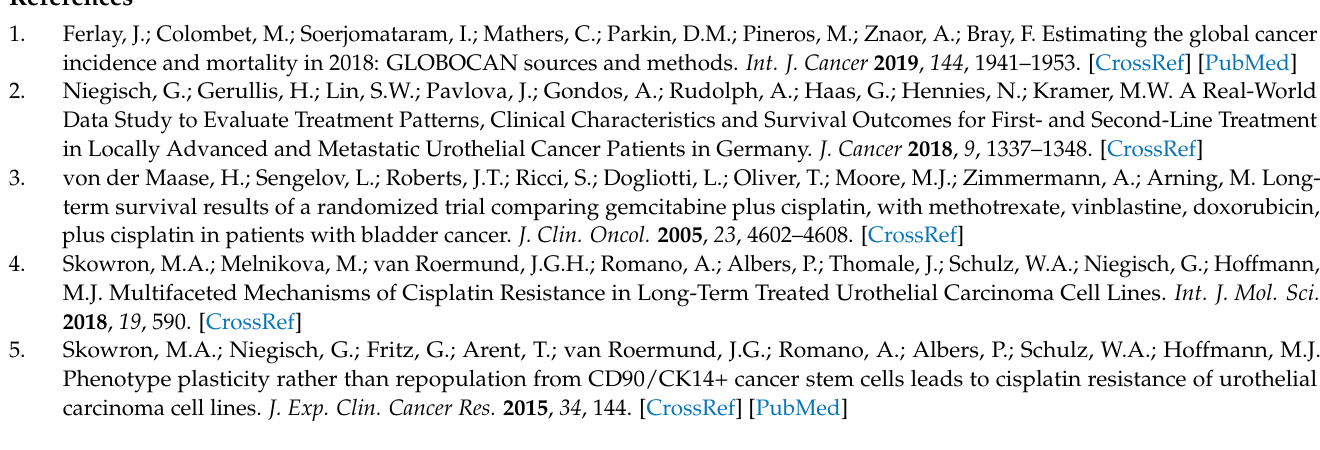
Figure S2: Impact of PLX treatment on HBLAK cells. Figure S3: Long term impact of PLX treatment on cell cycle. Figure S4: Synergistic effects on UCC by romidepsin treatment combined with PLX or cisplatin. Figure S5: Effect of combinations treatment with PLX on long-term proliferation and synergy of sequential combination treatment. Table S1: Antibodies used in this study. Table S2: Primer and PCR conditions used in this study. Table S3: Cell line-specific IC 50 doses of drugs applied in this study. Table S4: Fixed dose ratios applied for combination